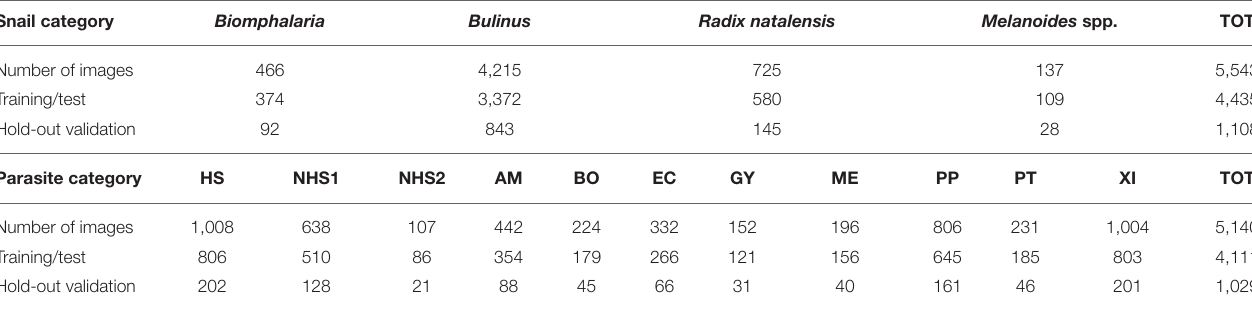
TABLE 1 | Summary of numbers of images for each snail genus and parasite morphotype; numbers of images for the split of training/test (80%) and hold-out validation set (20%). Snail category